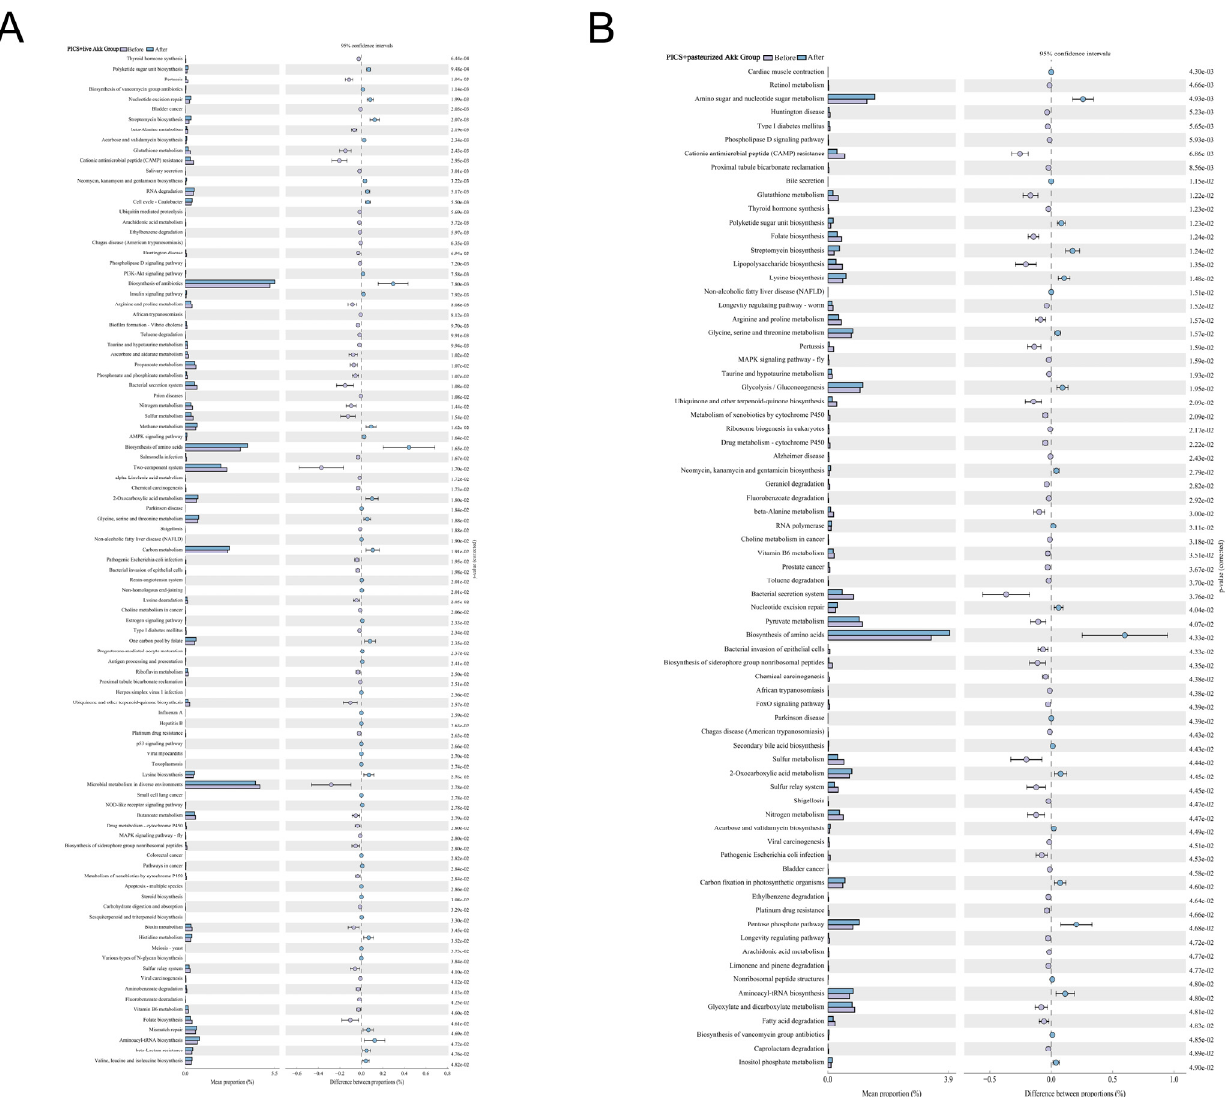
Figure 5. Pasteurized and live Akk regulates metabolic pathways of microbial communities. Fecal microbial community function differences against the KEGG database on Level 3 before and after ( A ) live Akk and ( B ) pasteurized Akk administration at day 14. For p -value, the letter e is used to mean "10 to the power of."